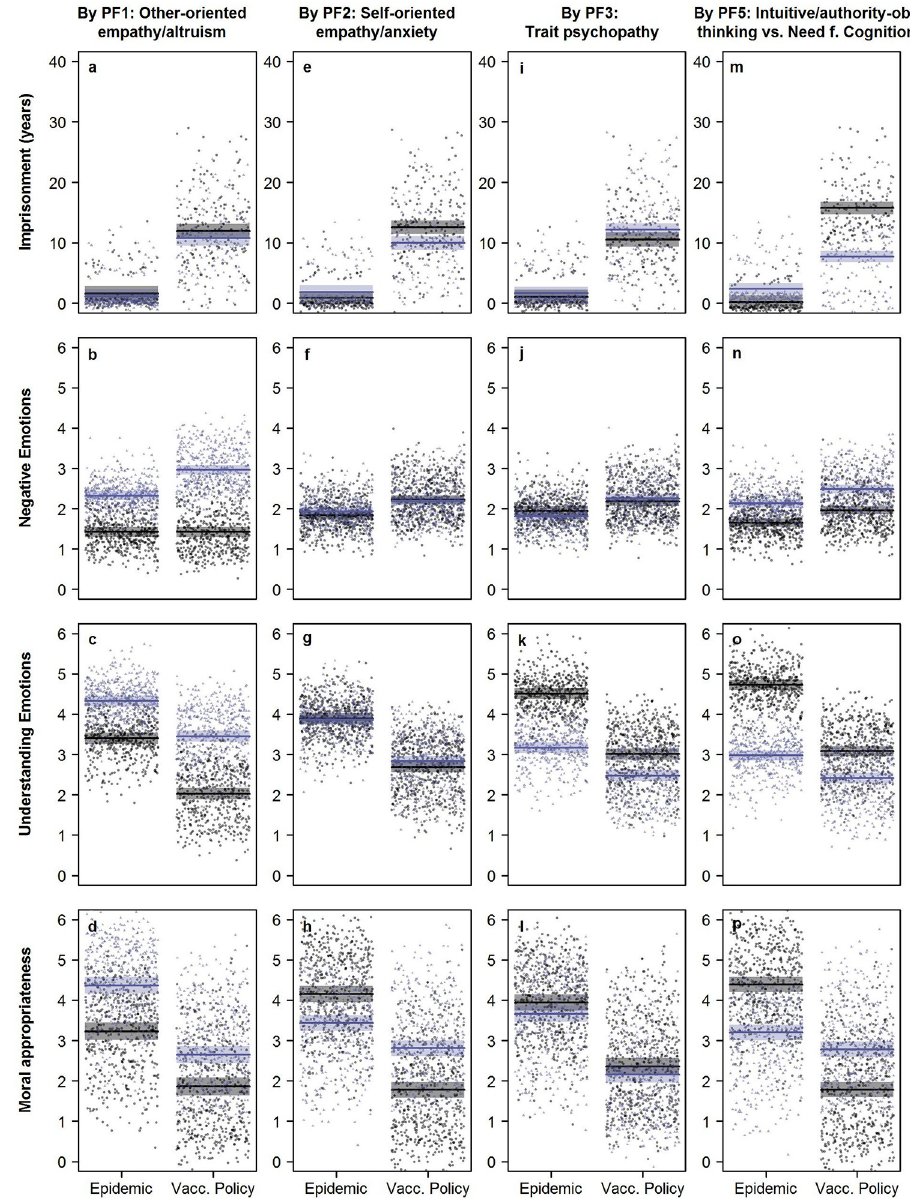
Fig 2. Visualization of the results of the linear mixed regressions. The graphs show punitive, emotional, and cognitive responses (see columns) to harmful omissions protecting a minority from deliberate harm ( epidemic ) or accidental harm ( vaccine policy ) depending on observers’ personality differences (see rows). Lower scores ( M -2 SD ) of the respective personality factor are indicated by grey color and higher scores ( M +2 SD ) by black color. Shaded areas represent 95% confidence